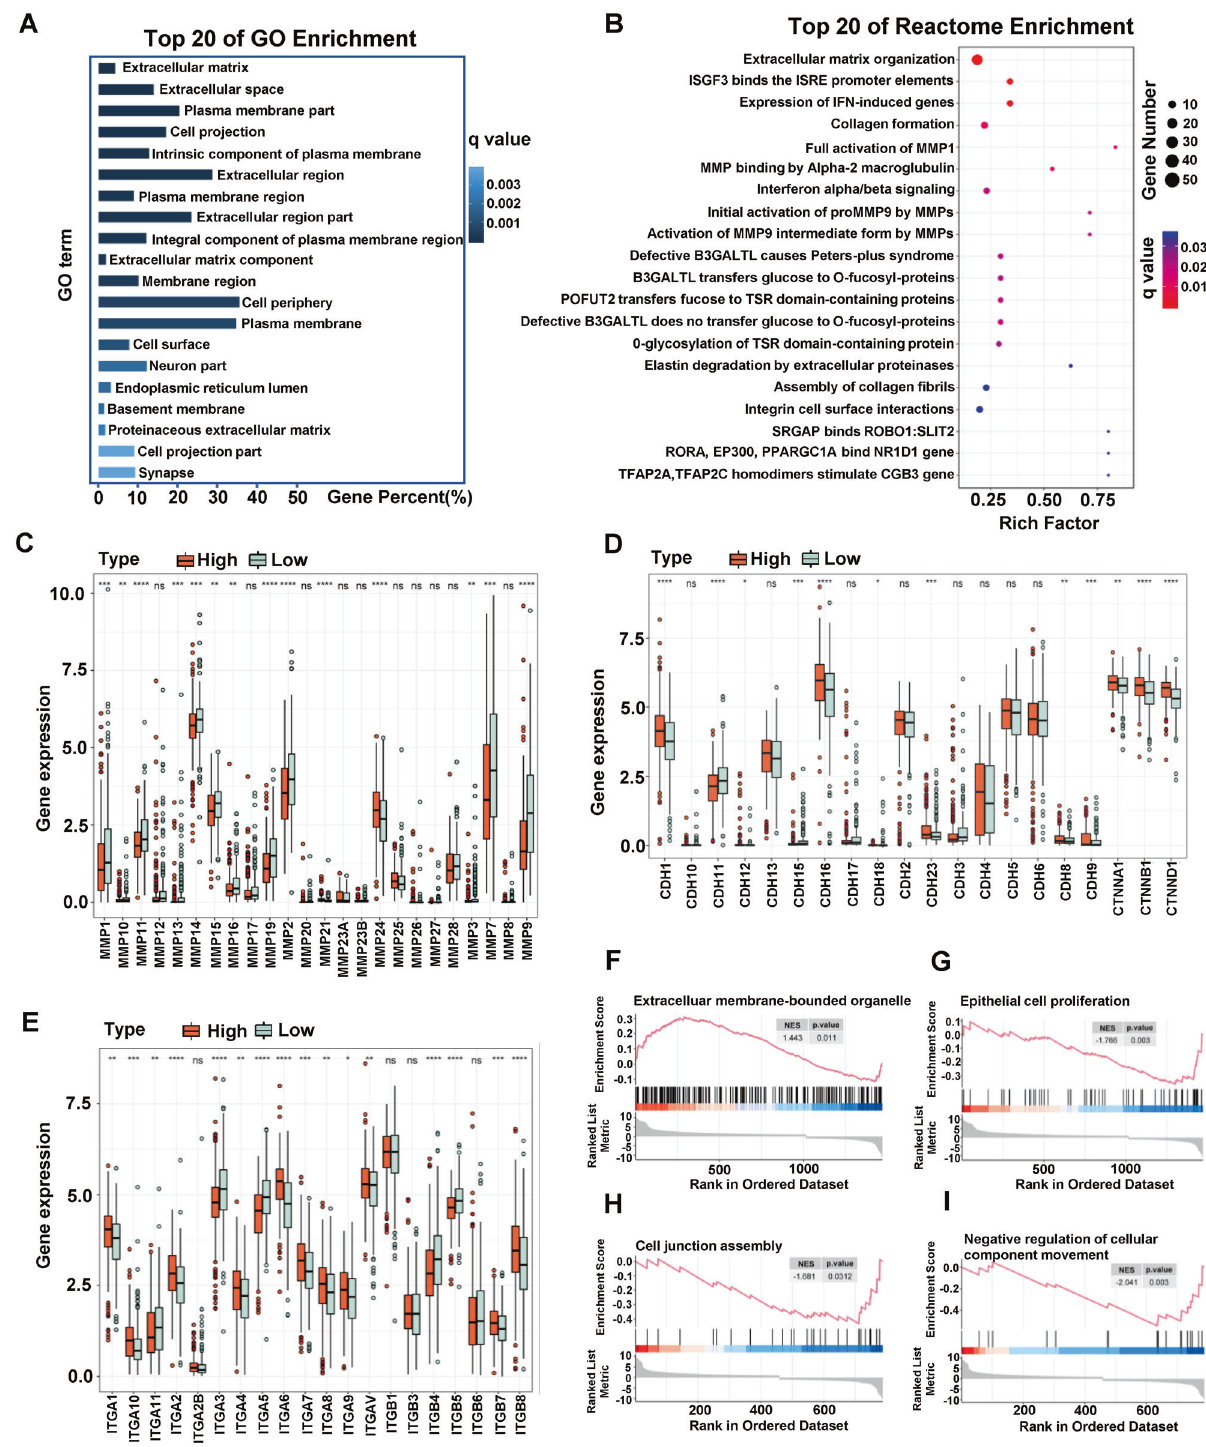
Fig. 6 LINC00472 is associated with extracellular matrix organization. A Top 20 of GO Enrichment of differentially expressed genes identi fi ed by RNA-Seq. B Top 20 of Reactome Enrichment of differentially expressed genes identi fi ed by RNA-Seq. C Relationship between the expression of LINC00472 and the level of MMPs family members in TCGA RCCC samples. D Relationship between LINC00472 and cadherin family members. E Relationship between LINC00472 and integrin subunit family members. GSEA showed the differences of extracellular membrane-bounded organelle ( F ), epithelial cell proliferation ( G ), cell junction ( H ), and negative regulation of cellular component movement ( I ) between high and low expression LINC00472 groups in TCGA RCCC samples.